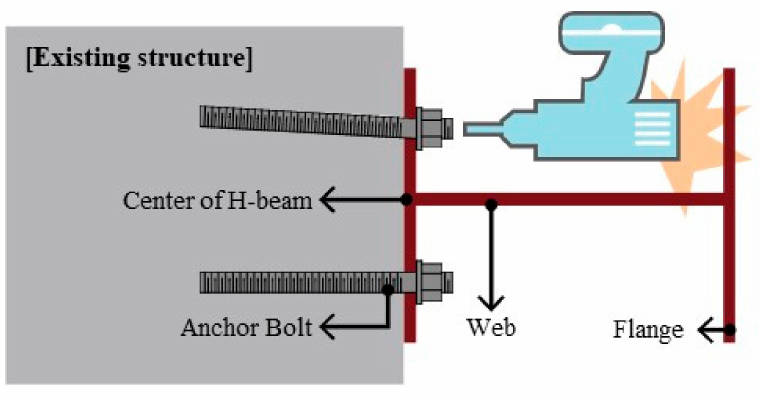
Figure 2. Conventional H-beam steel frame connection